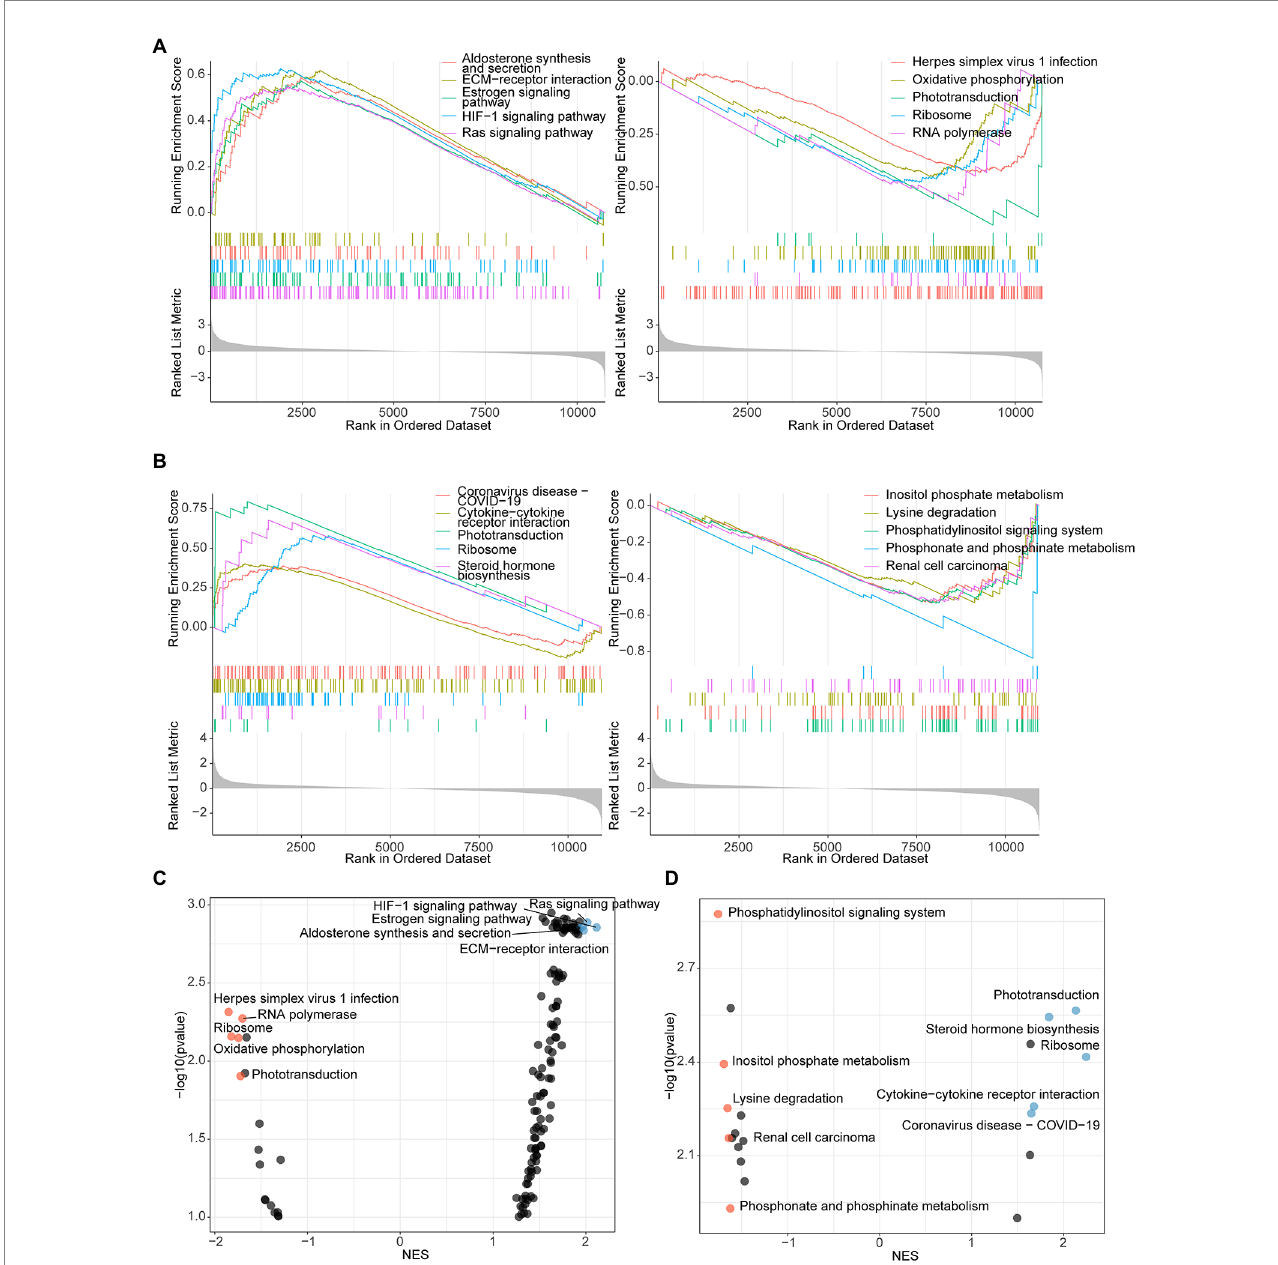
FIGURE 3 GSEA analysis identified pathways that participate in antibacterial process of L. reuteri . (A) Up- and downregulated enriched genes of top 5 pathways between E. coli F18ac and control groups. (B) Up- and downregulated enriched genes of top 5 pathways between E. coli F18ac with and without L. reuteri groups. Dot plots showing the up- and downregulated pathways in descending order on the y-axis by NES: left plot presents pathways compared between E. coli F18ac and control groups (C) ; right plot represents pathways compared between E. coli F18ac with and without L. reuteri groups (D) . Blue and yellow dots indicate top 5 upregulated and downregulated pathways,